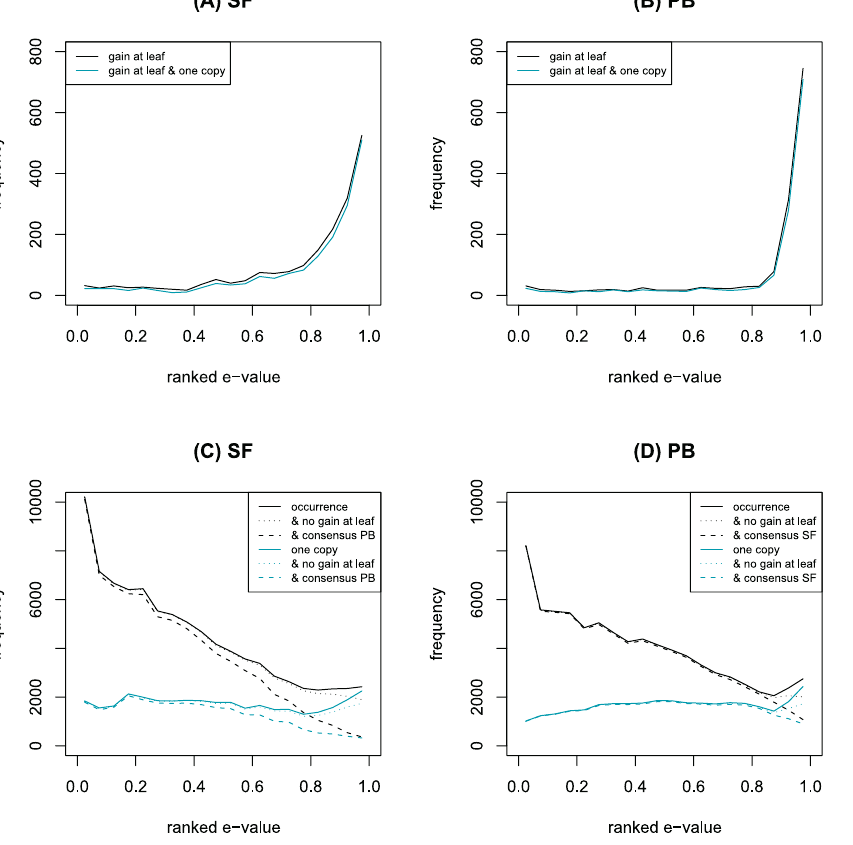
Figure 3. Ranked e-Value Distributions for SUPERFAMILY (SF) and PSI-BLAST (PB) Occurrences The ranked e-value is obtained by ranking the e-values in the set of all assignments (including multiple copies) and is normalised between 0 and 1. (A,B) Ranked e-value distributions for occurrences with a gain at leaf level. The peak at the righthand side might indicate a sudden increase in false positives. (C,D) Ranked e-value distribution for all occurrences. The dotted line indicates that occurrences with a gain at leaf level have been removed, and the striped line shows only consensus occurrences, which have been assigned by both SUPERFAMILY and PSI-BLAST. Occurrences caused by a single assignment (one copy) are shown in colour. Both the distributions for all occurrences and for occurrences caused by a single assignment show an increase at the righthand side, probably caused by false positives. This increase is not seen in distributions either where either predicted false positives are taken away or for consensus occurrences.